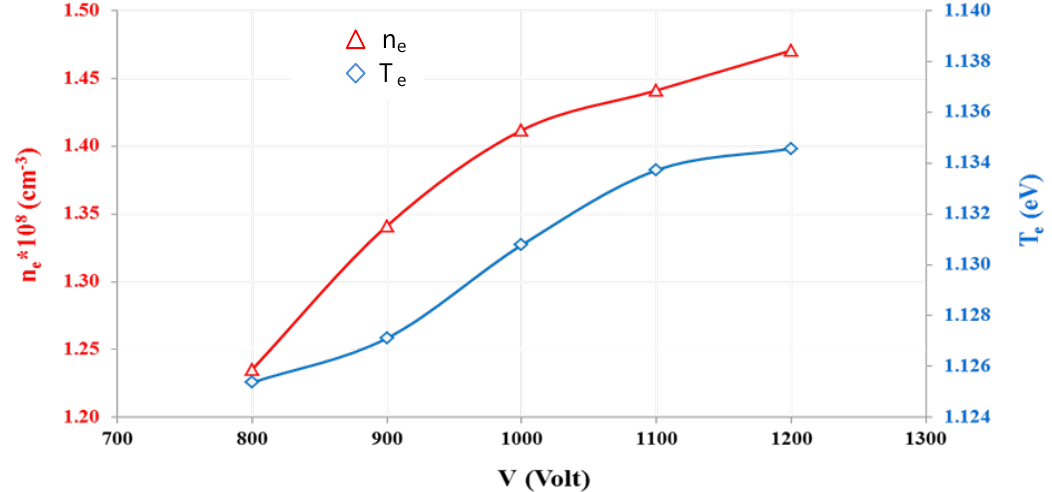
Fig. 5: The variation of electron temperature and electron density with DC